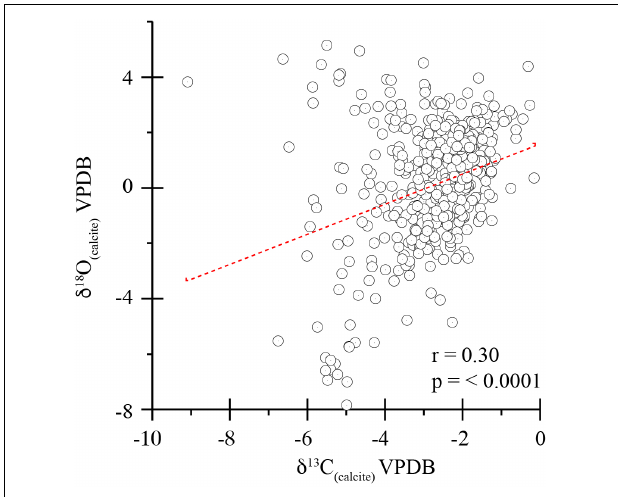
FIGURE 9 | Scatter plot comparing Holocene sediment δ 18 O ( calcite ) and δ 13 C ( calcite ) values.